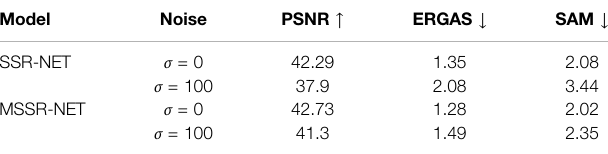
TABLE 9| Qualitative results on Pavia Universitydataset incase oftwo inputs: HR MSI and noisy LR HSI with σ standard deviation. Four spectral bands of HR MSI are generated according to Type 1 model and LR HSI is 4× downsampled.